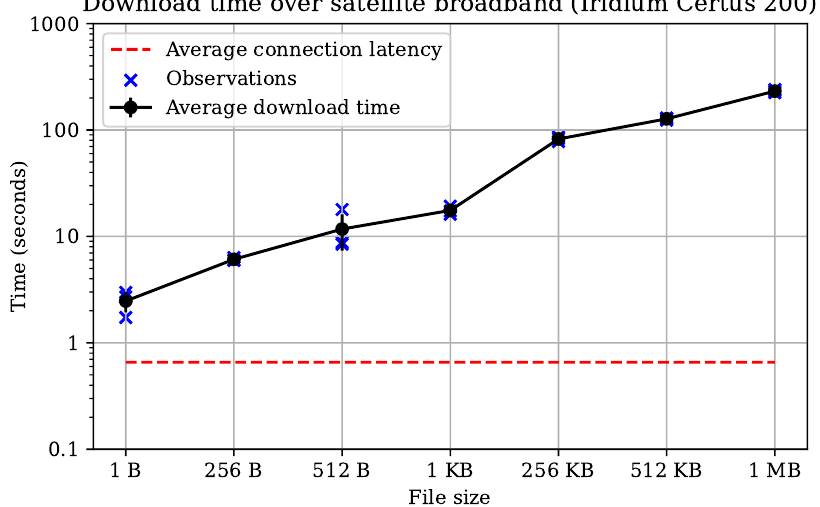
Figure 6. Observed time to download files at various sizes over a satellite broadband connection. Time is represented in a logarithmic scale on the y -axis, to show average download times of the various files, represented on the x -axis by their sizes. The average connection latency observed throughout every established connection during this experiment is also shown.